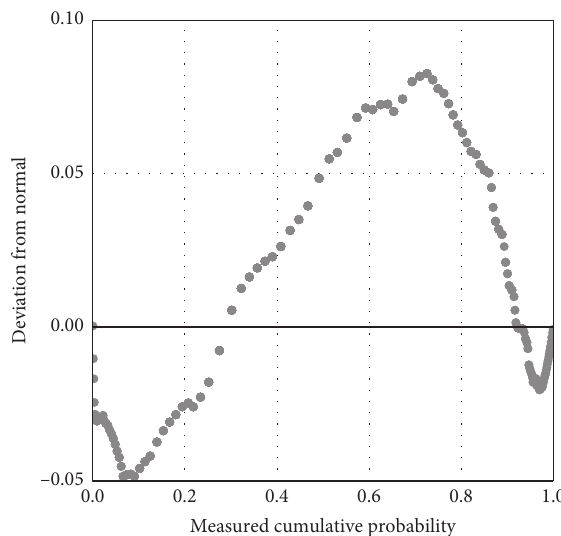
Figure 2: Detrended normal P − P diagram during reaction time.